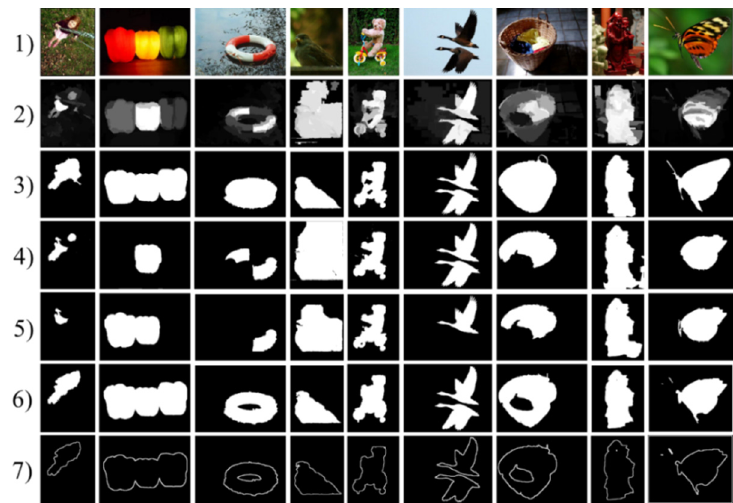
Figure 10. Experimental results of outer contour generation. From top to bottom rows: (1) input images, (2) saliency maps (grayscale images), (3) ground truth images, (4) ATT_Cuts results, (5) RC_Cuts results, (6) results of the proposed method, (7) boundary detection using the Canny edge technique.